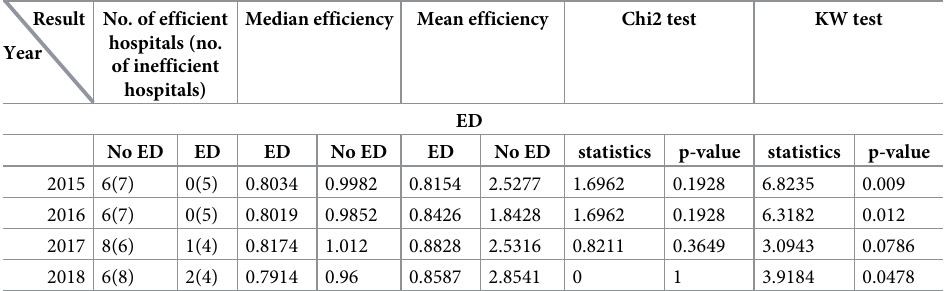
Table 9. Efficiency of commercialized hospitals with respect to an ED ( traditional approach). Result